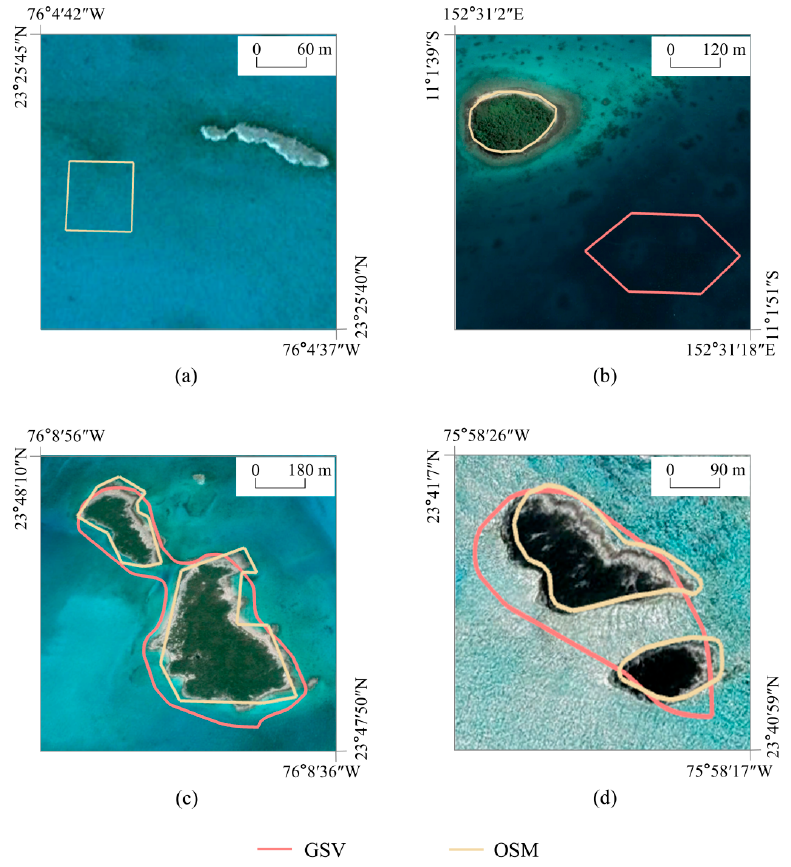
Figure 8. Overlapping the two island datasets with corresponding satellite images ( a – d ) in Google Earth, in order to understand the results in Table